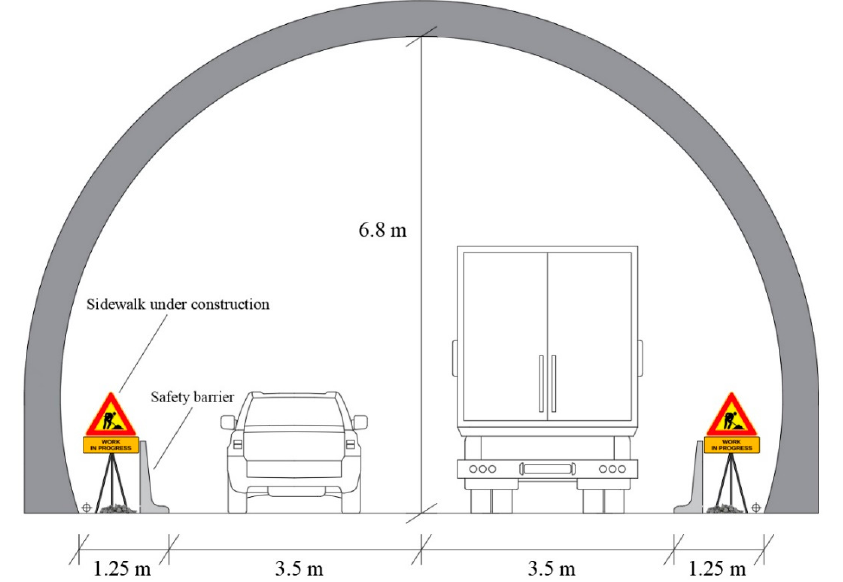
Figure 1. Cross-section of the investigated tunnel.